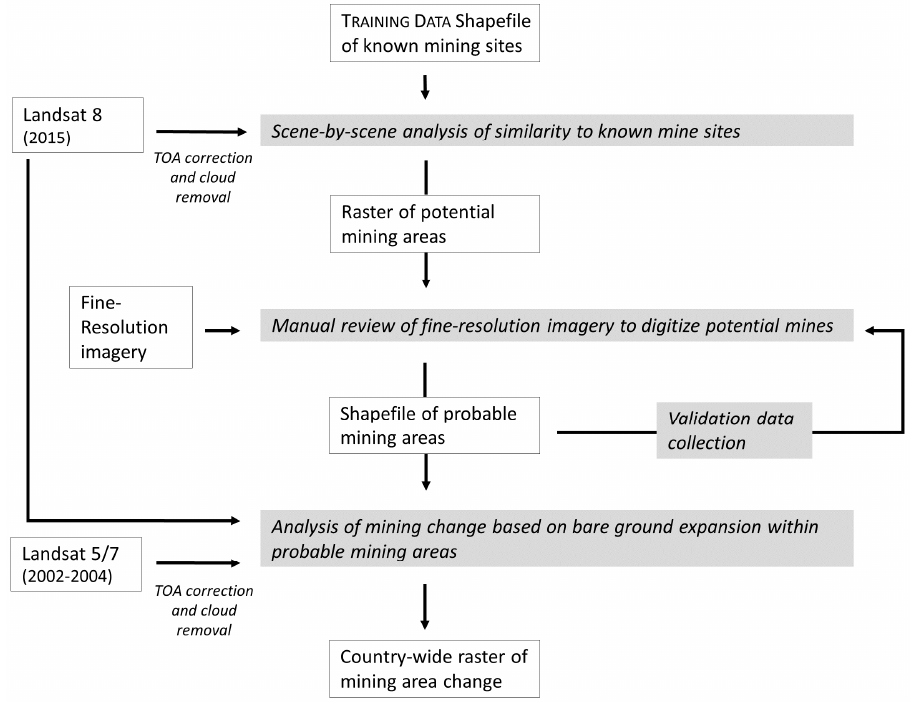
Figure 1. Inputs and processes in the identification of mining areas and mining area change. Top of Atmosphere correction is abbreviated as “TOA correction”.